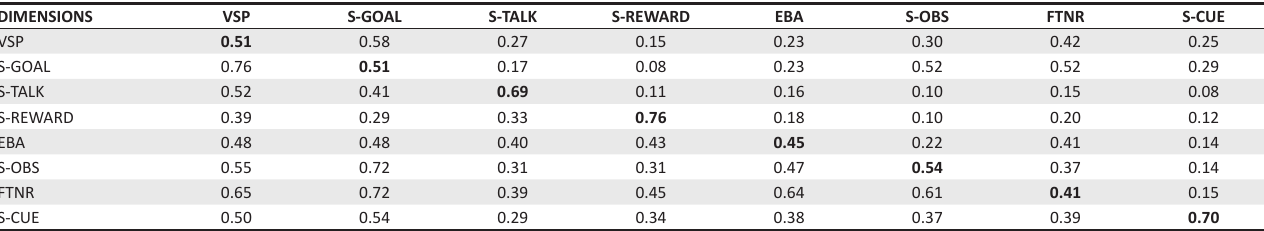
TABLE 6: Inter-correlations between Latent RSLQ dimensions, Average variance extracted (AVE) and shared variance estimates. DIMENSIONS